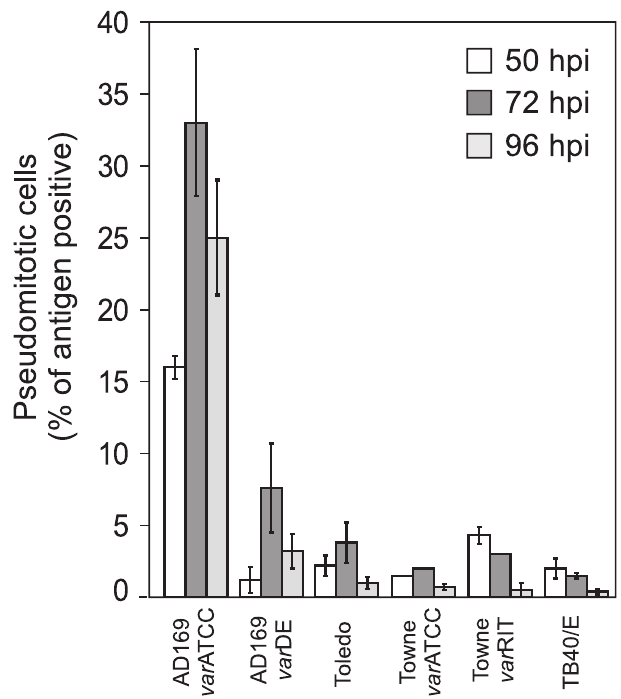
Figure 1. Pseudomitosis Levels Induced by Commonly Used CMV Strains Confluent HFs infected with the indicated CMV strains for 50, 72, and 96 h were immunostained with monoclonal antibodies (mAb) against c - tubulin 1 and against IE1/IE2. The percentage of IE1/IE2 þ pseudomitotic cells was determined after counting at least 500 cells for each strain at each time point [7]. Mean percentages and standard deviation from a representative experiment are